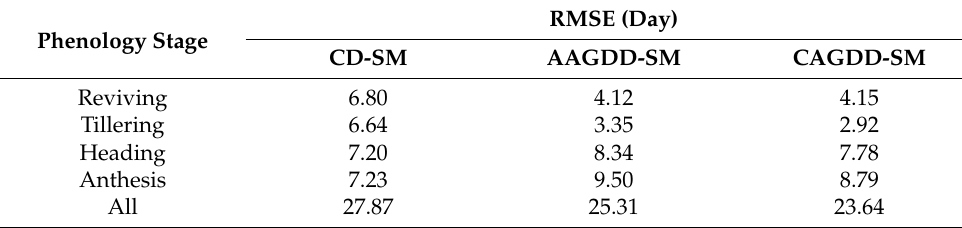
Table 5. Precisions of different phenological extraction